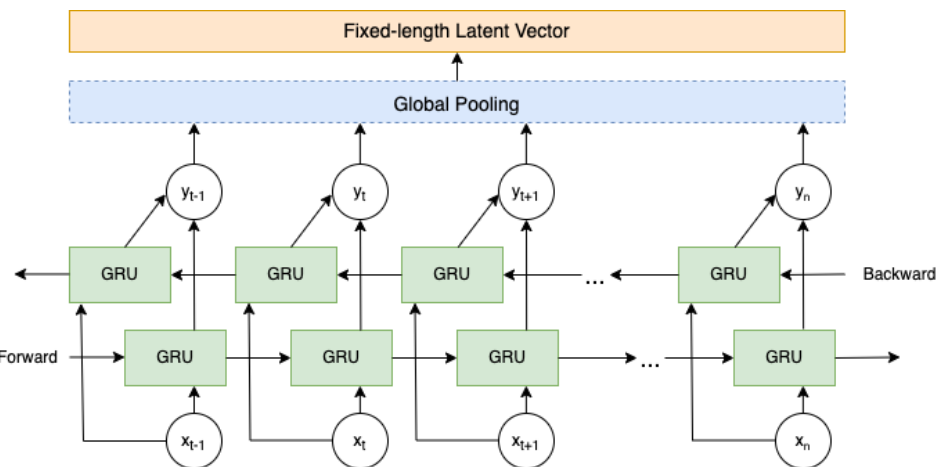
Figure 5. Architecture of TA module. TA module is based on the architecture of Bi-directional GRU